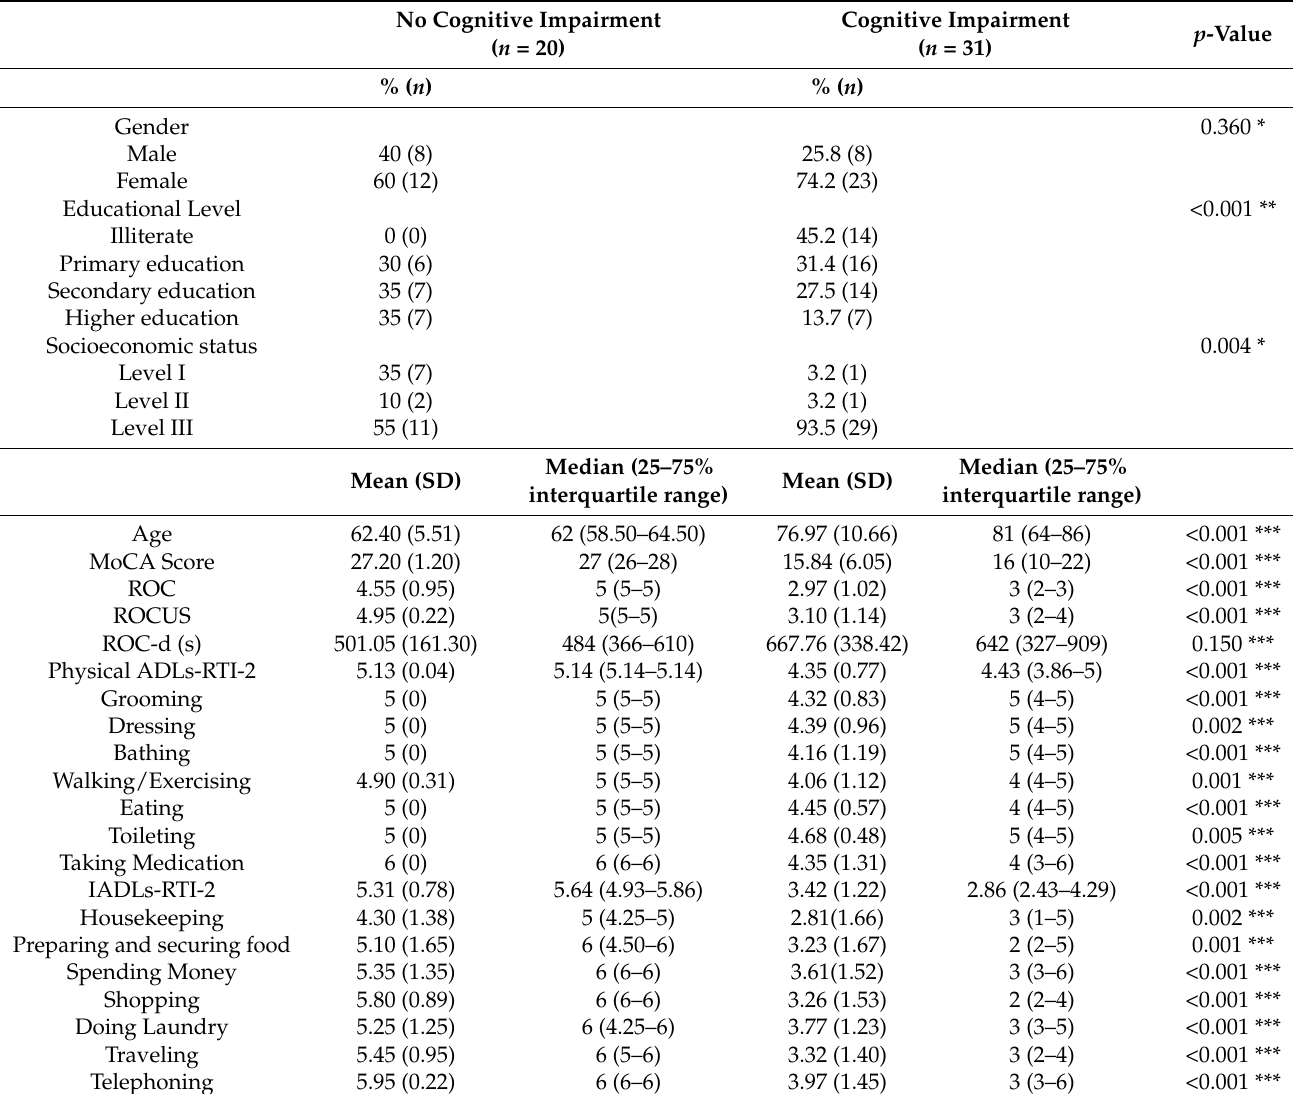
Table 3. Characteristics of the sample and differences between the two groups of comparison.